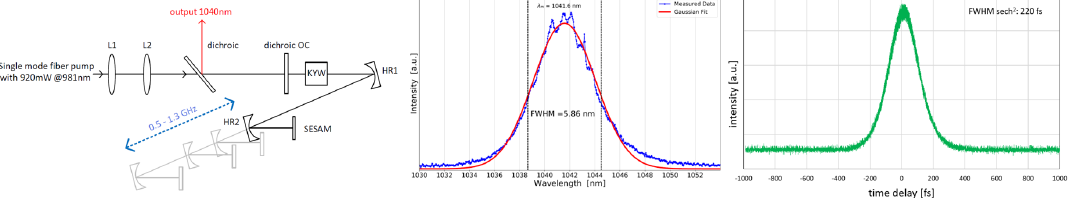
Fig. 1 Laser cavity setup (left), optical spectrum (middle) and SHG intensity autocorrelation trace (right) of a 1.23 GHz pulse repetition rate